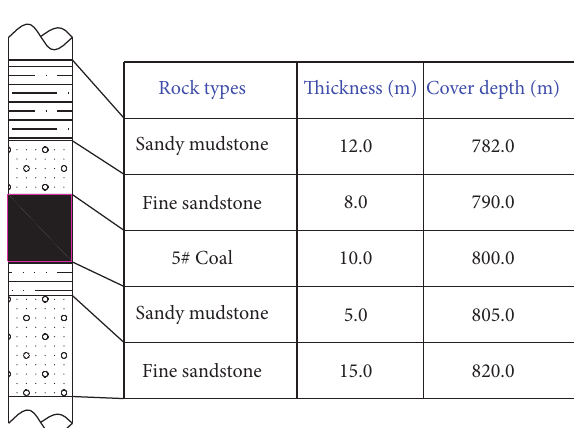
Figure 2: Nearby stratigraphic histogram of 5202